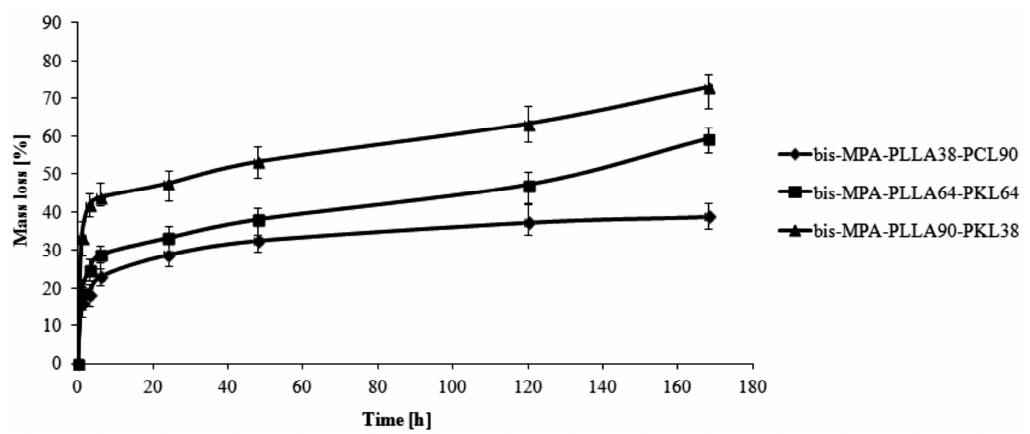
Figure 4. Effect of hydrolytic degradation time on the WL of the branched copolymeric matrices.